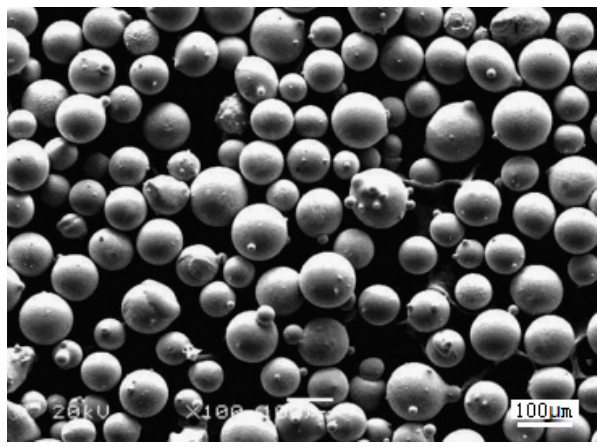
Figure 1. Micromorphology of the Co ‐ based alloy powder used in the experiments.